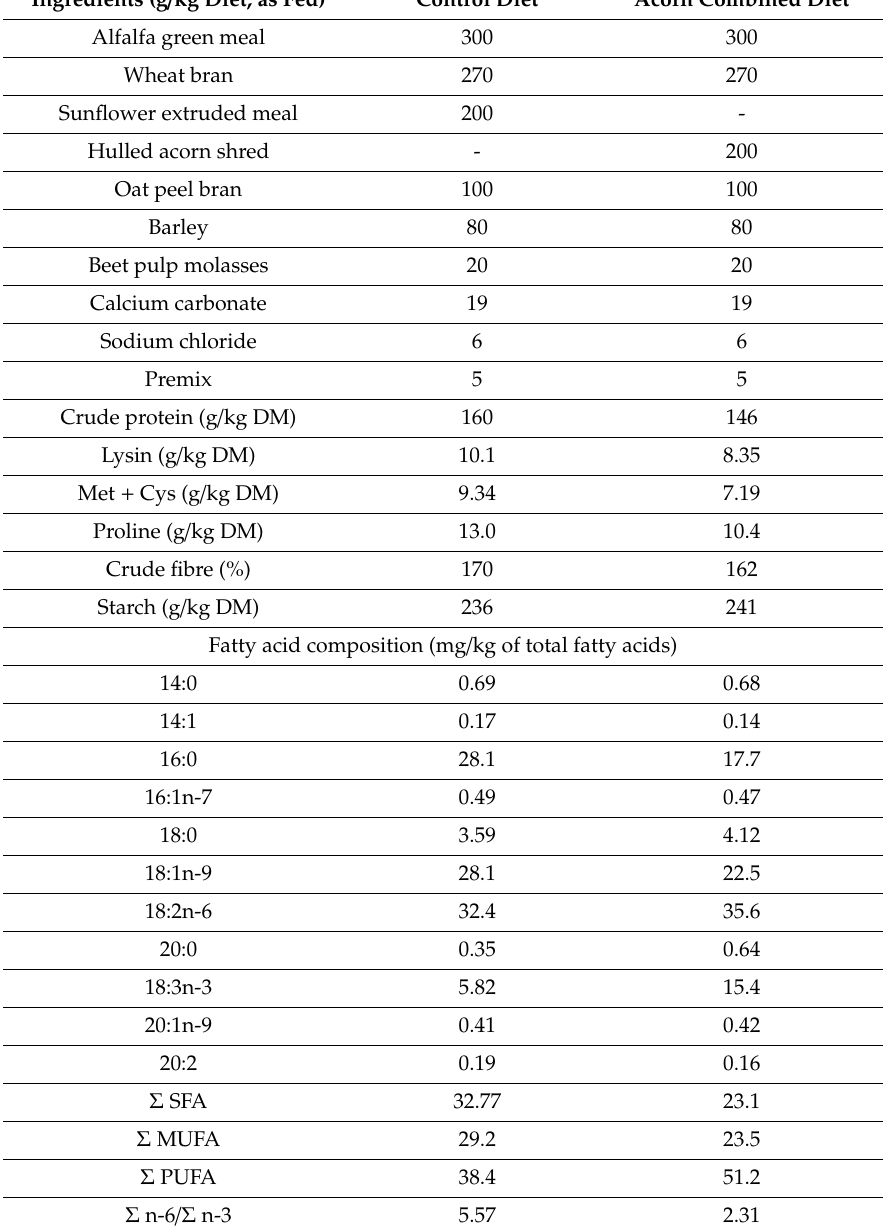
Table 2. Analysed nutrient composition and fatty acid profile of the two experimental